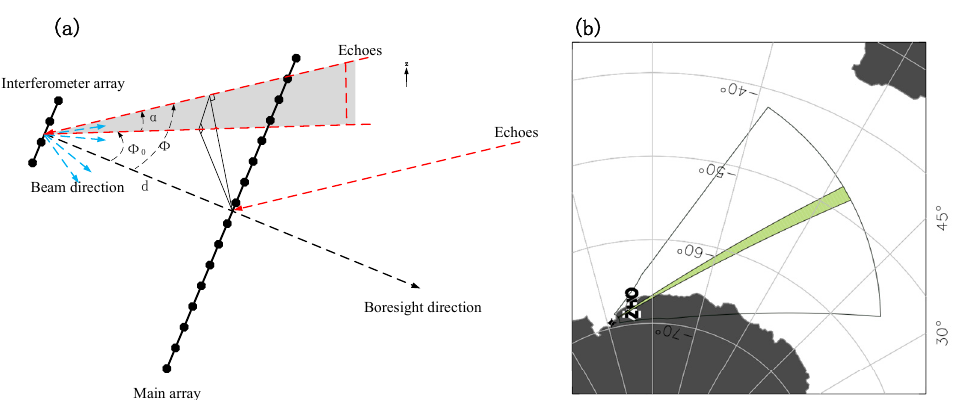
Figure 1. ( a ) The positional relationship diagram of main array and interferometer array of SuperDARN; ( b ) field of views (FOVs) of the Zhongshan high frequency radar (ZHO).